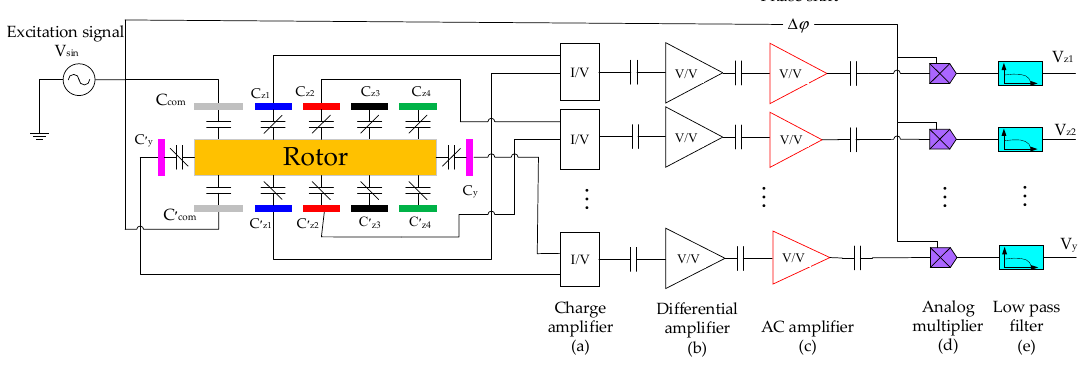
Figure 7. A schematic of the rotor displacement sensing circuit.